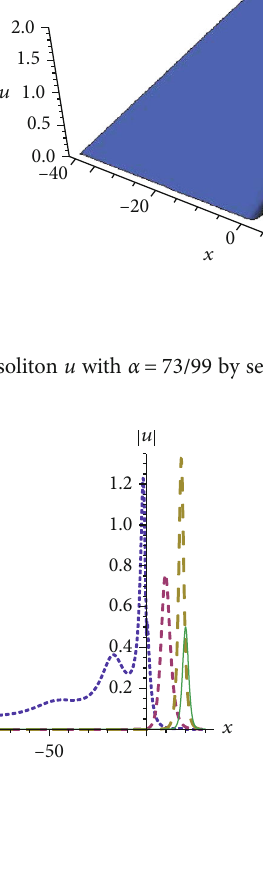
Figure 3: Pro fi les of fractional one-soliton ∣ u ∣ with di ff erent orders by selecting a = 1 , b = 2 , c = 3 , k 1 = 1 , p 1 = 1/2 , σ = 1 , ξ ð and t = 0